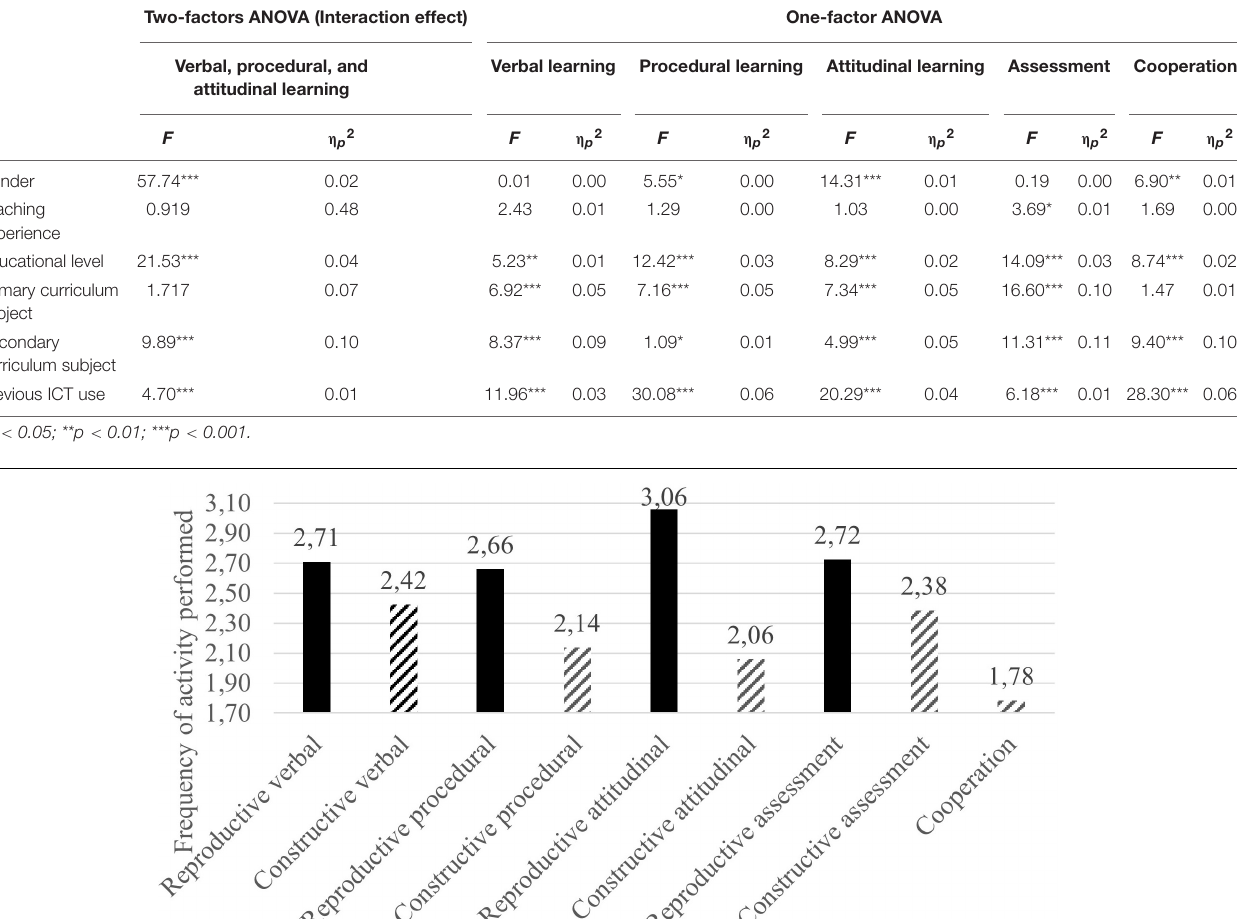
TABLE 5 | Influence of different variables on the frequency of activities for each dimension.